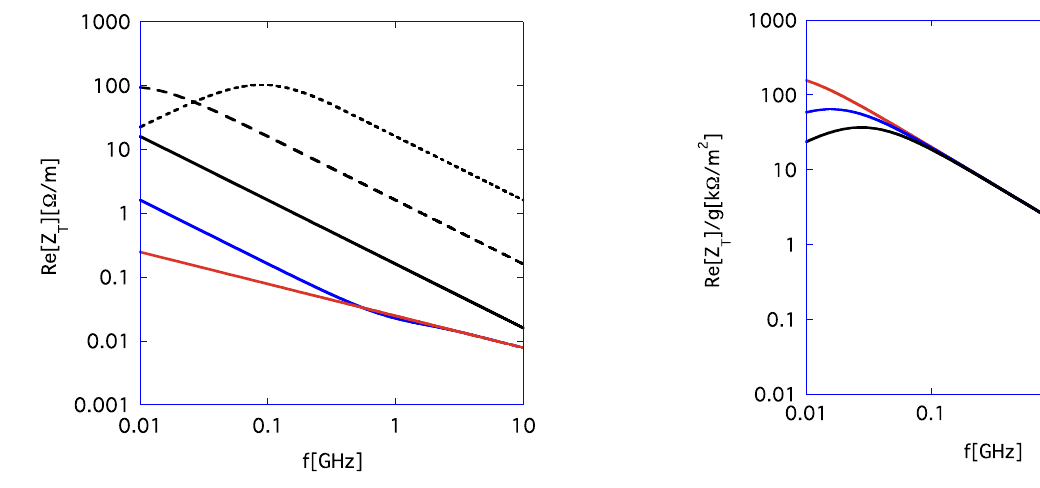
FIG. 7. (Color) The dependence of the real part of the transverse resistive-wall impedance of a uniform beam pipe (no insert) on the thickness of the chamber. The length of the beam pipe g ¼ 8 mm . Lorentz factor (cid:6) ¼ 1000 . The red, the blue, the black, the black dashed, and the black dotted lines show the cases that the chamber thickness t is equal to infinity, 10 (cid:13) m , 1 (cid:13) m , 100 nm, and 10 nm, respectively. The impedance for finite thickness starts to deviate from that for infinite thickness at the frequency where the skin depth exceeds the chamber thickness.